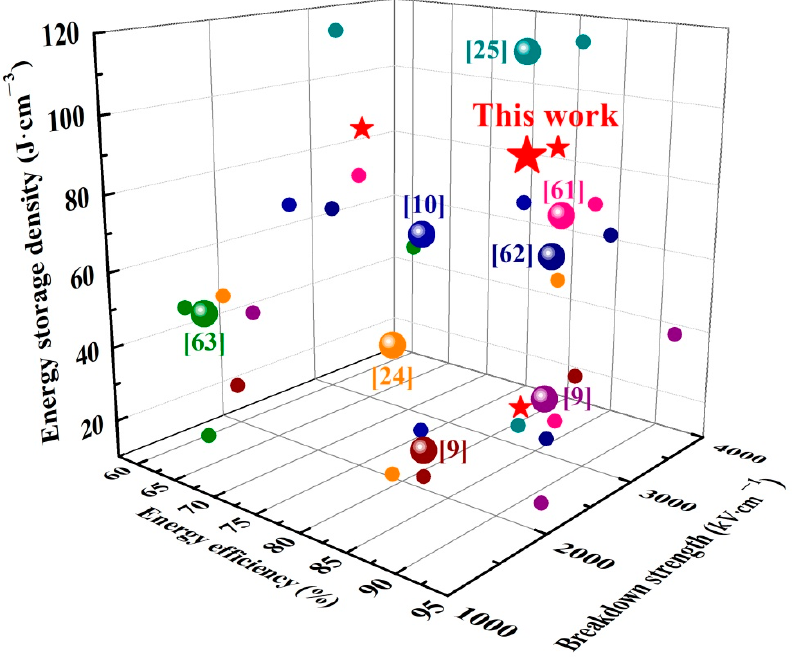
Figure 7. Summary of recently reported the core parameters of E b , W rec and η for energy storage properties of representative Aurivillius ferroelectrics film.